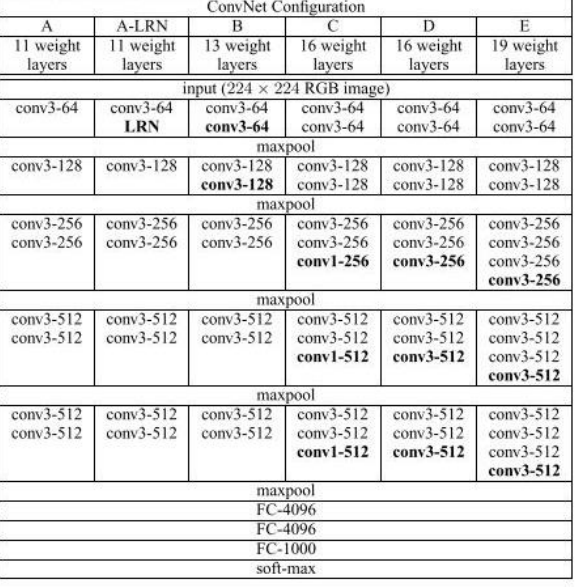
Figure 3. VGG Network Architecture proposed by